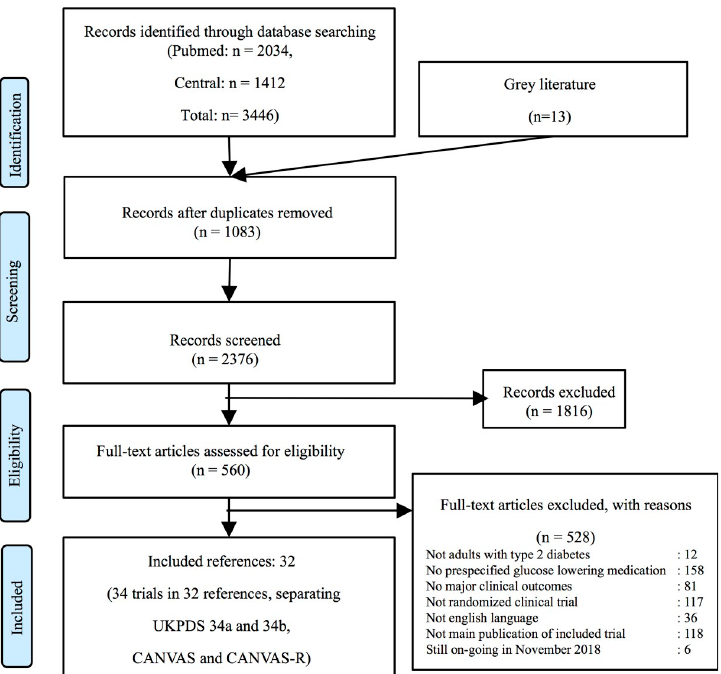
Fig 1. Flow diagram of bibliographic search (following PRISMA